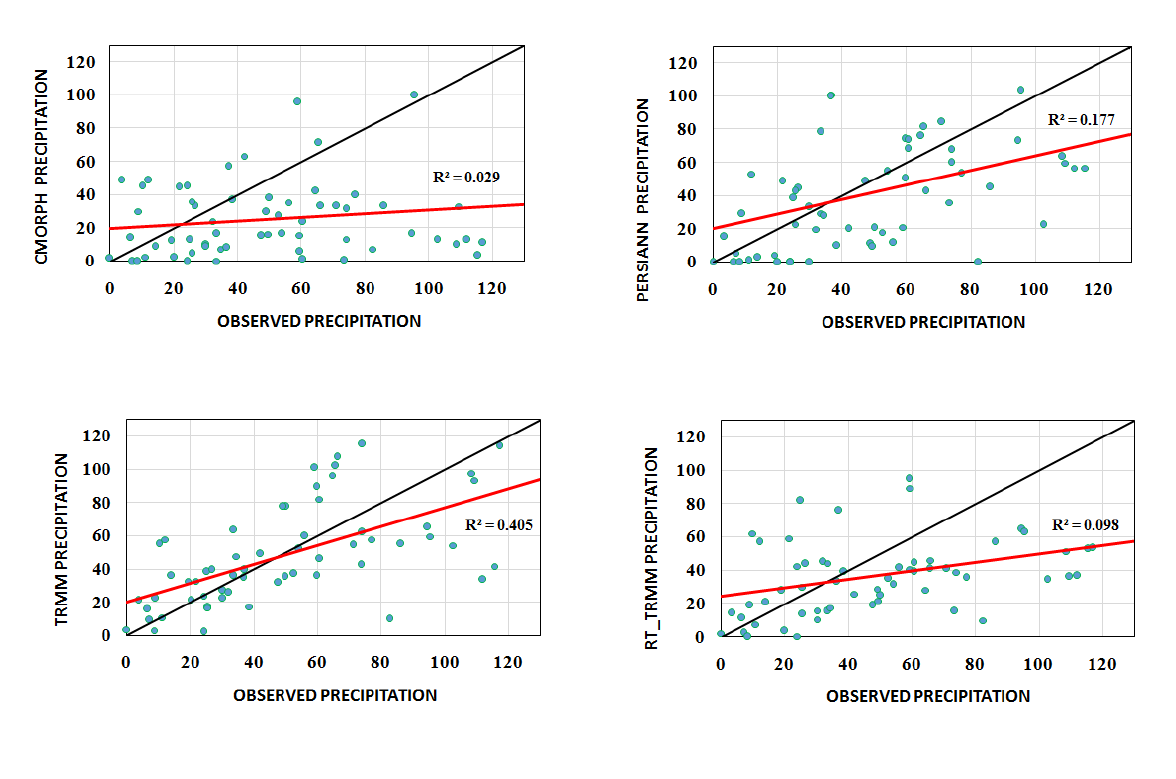
Figure 2: Monthly precipitation of Tamer station along with precipitation reported by satellite data station